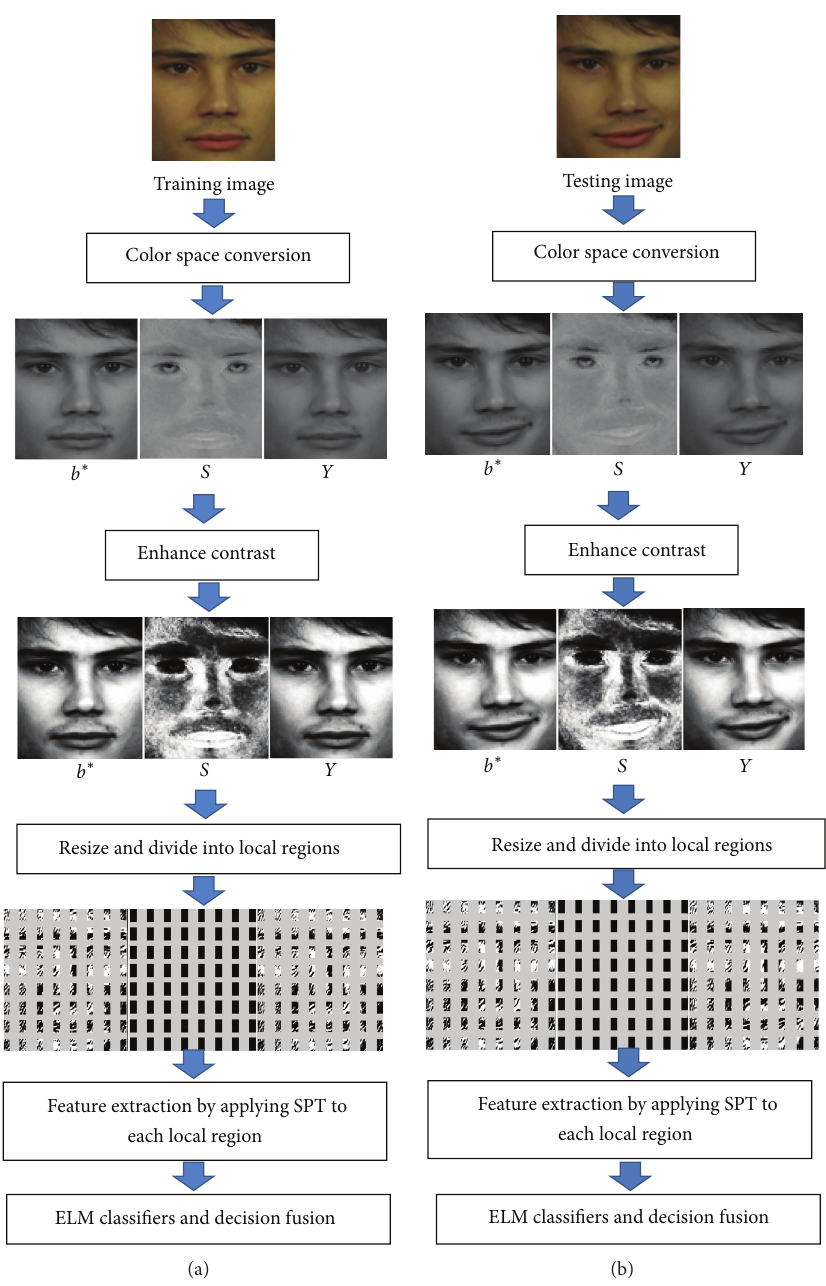
Figure 4: The block scheme of the proposed LCSPT